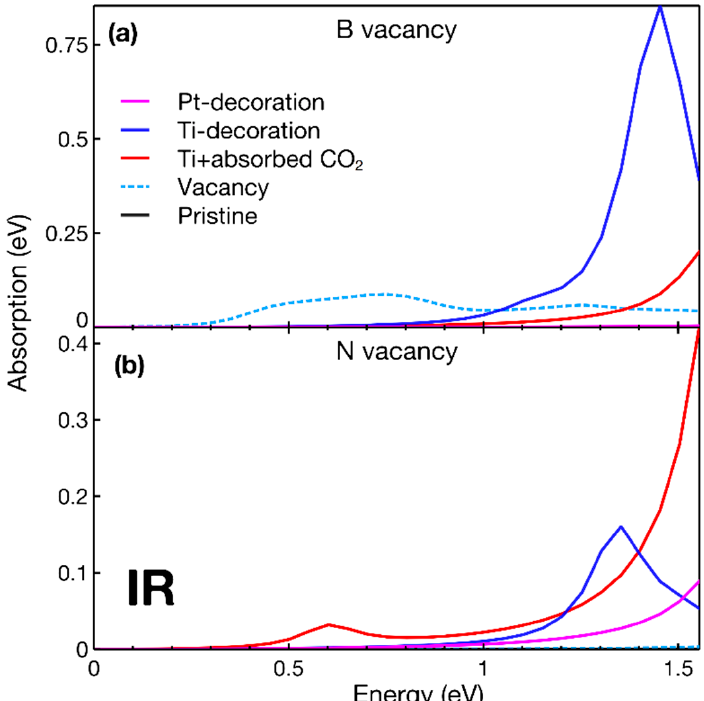
Figure 3. Absorption in the infrared region for the cases considered. In ( a ) we see the cases with the B atom removed from the hBN surface, while in ( b ) we see those with the N atom removed. There is an acute increase in the absorption when titanium is a dopant. There is also a high response for CO 2 .